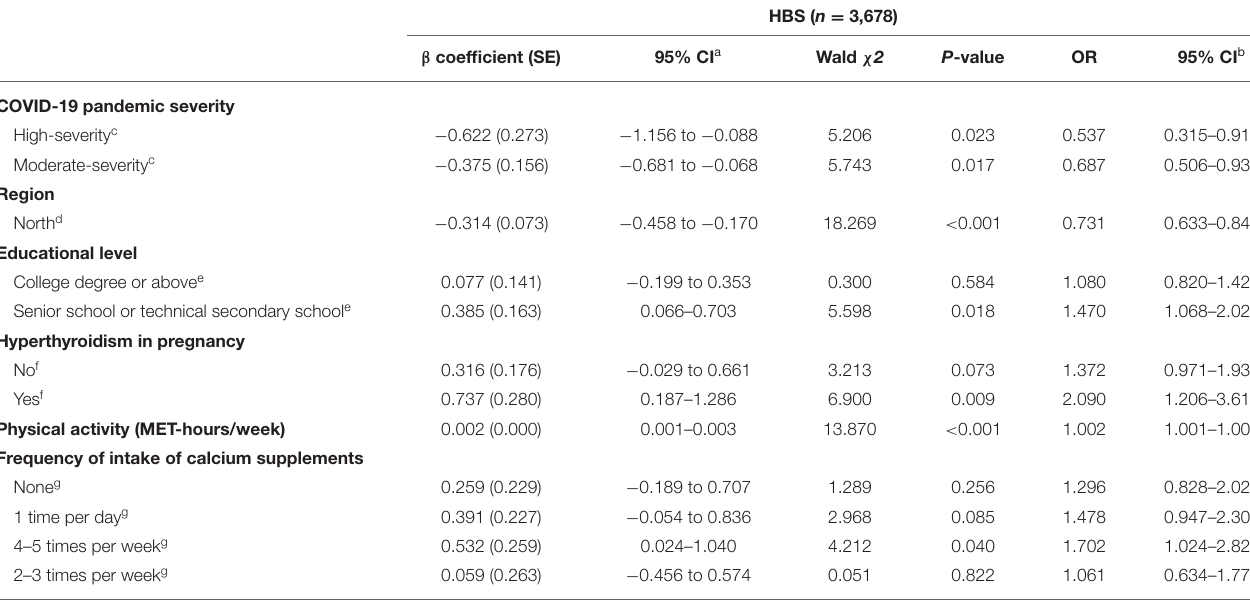
TABLE 3 | Associations of diet quality (HBS) with COCID-19 pandemic severity, demographic factors, and health-related